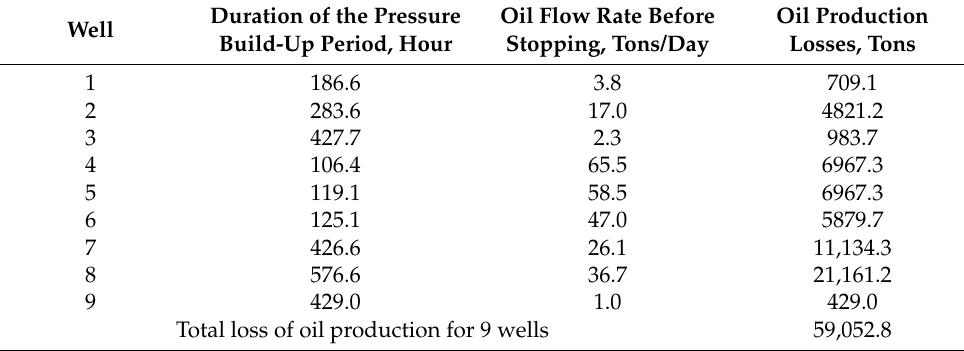
Table 1. Loss of oil production during the hydrodynamic studies of